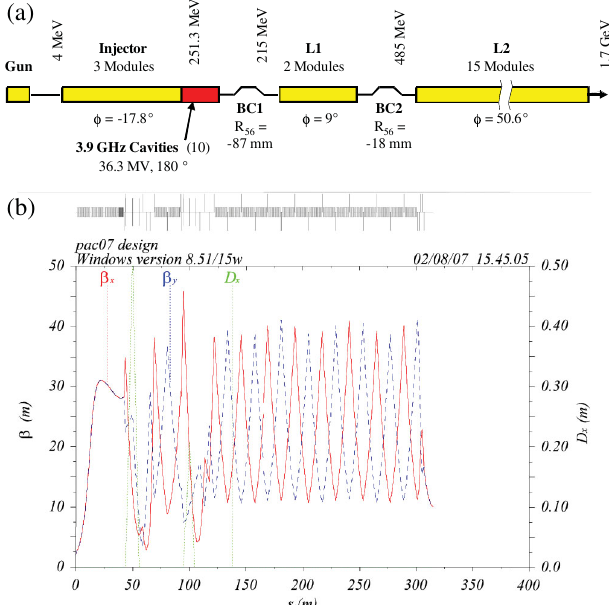
FIG. 1. (Color) (a) Schematic of the WiFEL preliminary bunch compressor design, optimized for zero current or trapezoidal bunches. Each linac module contains eight 1.3-GHz supercon- ducting cavities. (b) Lattice functions plotted by the MAD-with- acceleration code.